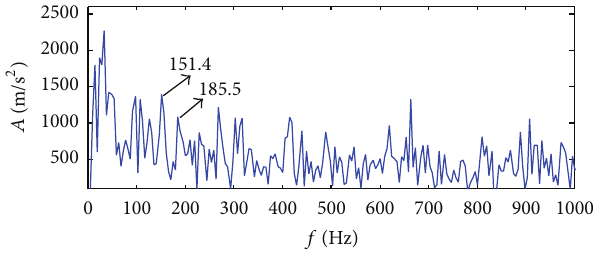
Figure 8: Hilbert demodulation spectrum.